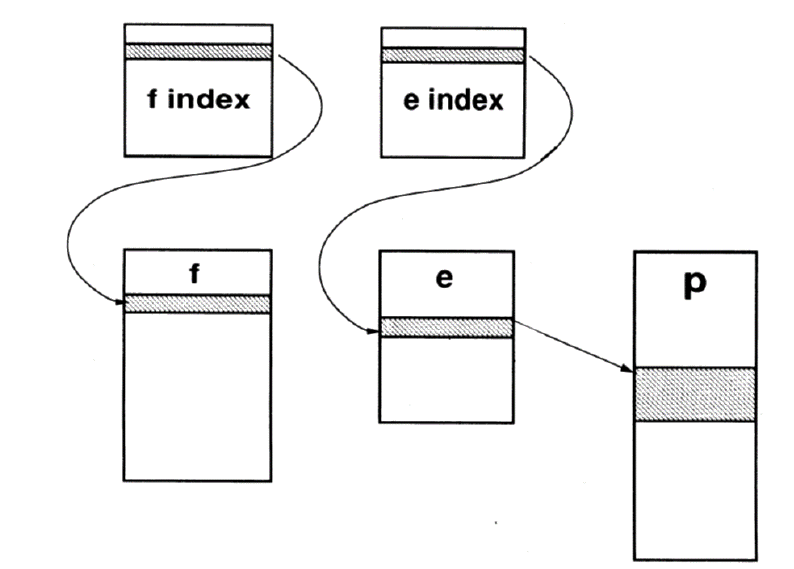
Figure 2. TOPbase file structure showing the e , f , p datasets and the e and f indexes. Reproduced from Figure 1 of [28].